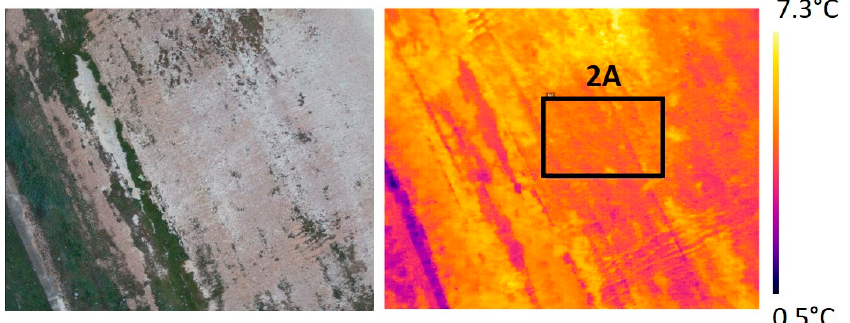
Figure 8. Visible (RGB) and infrared (IR) images of a central landfill area (with bare soil and low vegetation), acquired during the winter survey (February 2020) of Scala Erre.